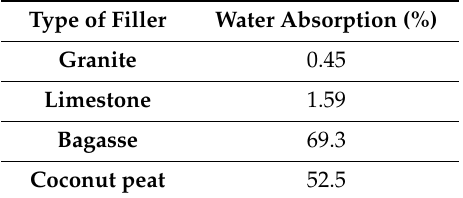
Table 1. Moisture absorption for di ff erent fillers.